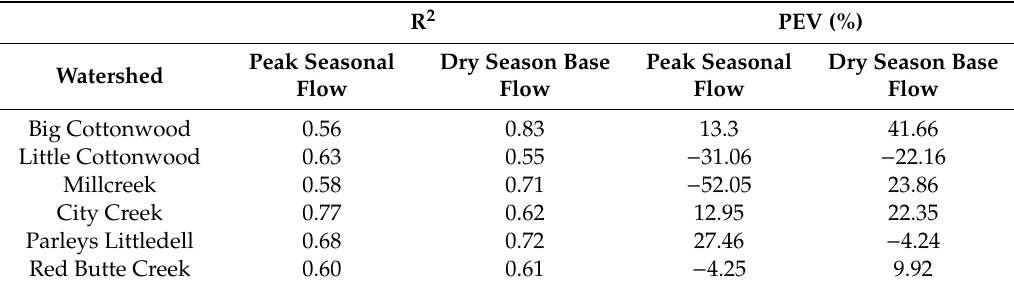
Figure 10. Observed and simulated volume of dry season base flow of the studied watersheds. Table 8. Statistical analysis of seasonal flow volume for historical baseline